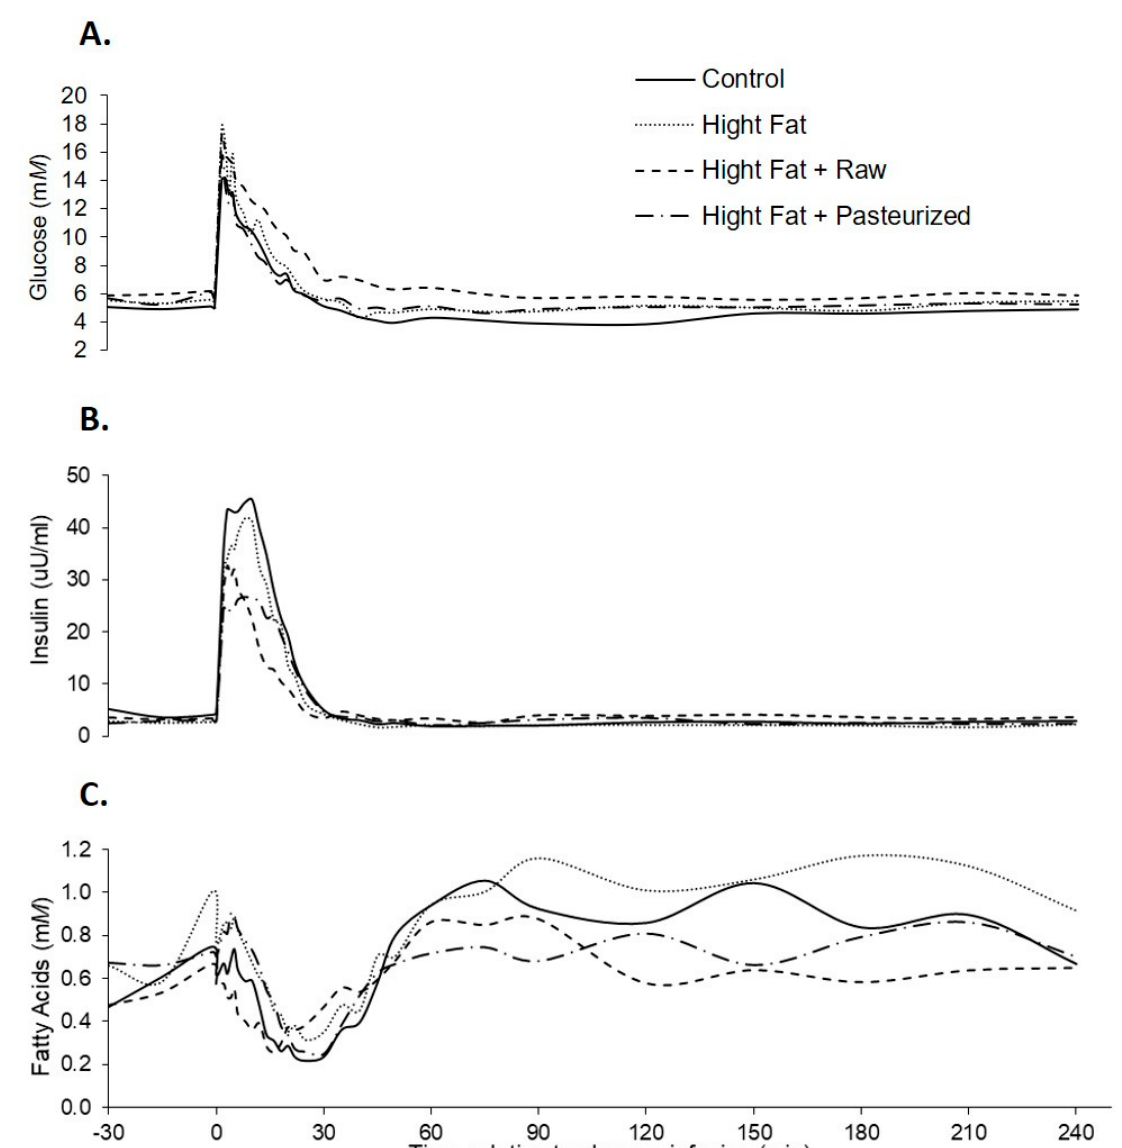
Figure 1. Plasma glucose ( A ), insulin ( B ), and fatty acids ( C ) responses to an in vitro glucose tolerance test (IVGTT) in female grower pigs ( n = 20) fed either of the following: control, high fat, high fat + 500 mL/day pasteurized camel milk, or high fat + 500 mL/day raw camel milk. The glucose infusion occurred at time 0.